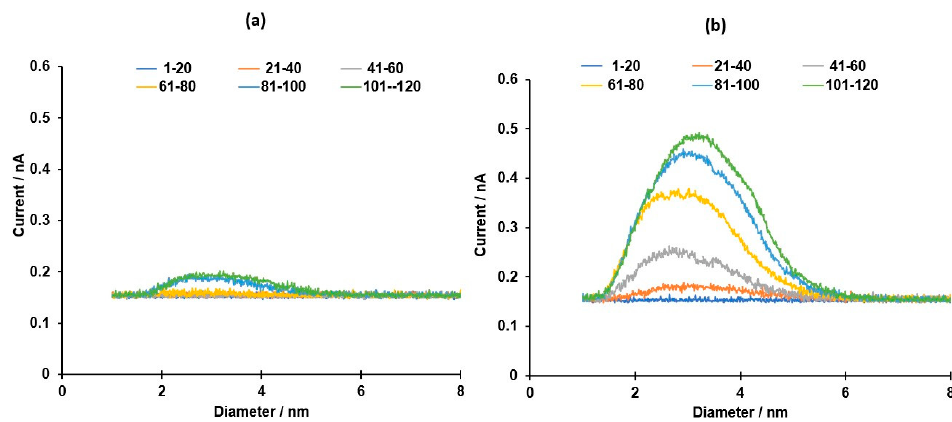
Figure 1. Low ( a ) and high ( b ) power spectra of Fe 3 O 4 . In addition to size pre-selection via MesoQ software, at fixed values of WD and temperature, size and size distribution of IONPs can be controlled changing the flow rate of the inert gas [42] in relation to the power and the throttle position (Table S3, Supplementary Information). To assess the effect of the inert gas (argon) flow rate at fixed WD and room temperature (20 ◦ C), in this work, IONPs were generated using different flow rates and by applying enough power to achieve a stable plasma. The results depicted in Figure 2 show that IONPs production was not as high when slower argon flow rates were used (e.g., 30 sccm) and the production was at its maximum with the intermediate values of flow rate tested (70 sccm), when currents higher than 0.5 nA were recorded. The argon flow rate seems to affect not only the amount of particles generated, but also their size and distribution. In fact, at an argon flow rate of 30 sccm IONPs with size around 2 nm were produced, while flow rates of both 70 and 100 sccm produced particles with size between ~ 1–6 nm (Figure 2).